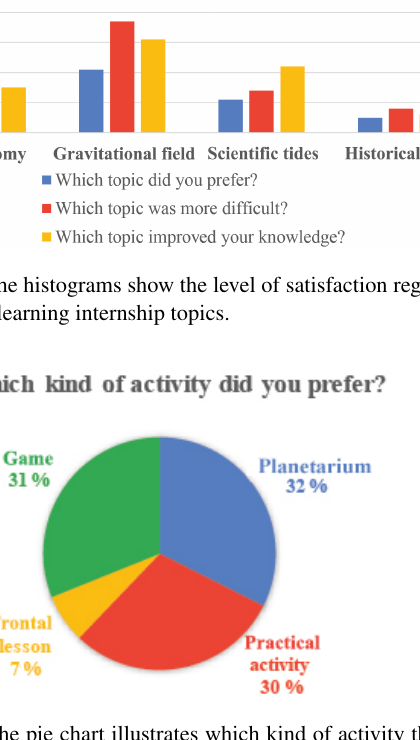
Figure 13. The pie chart illustrates which kind of activity the stu- dents prefer.